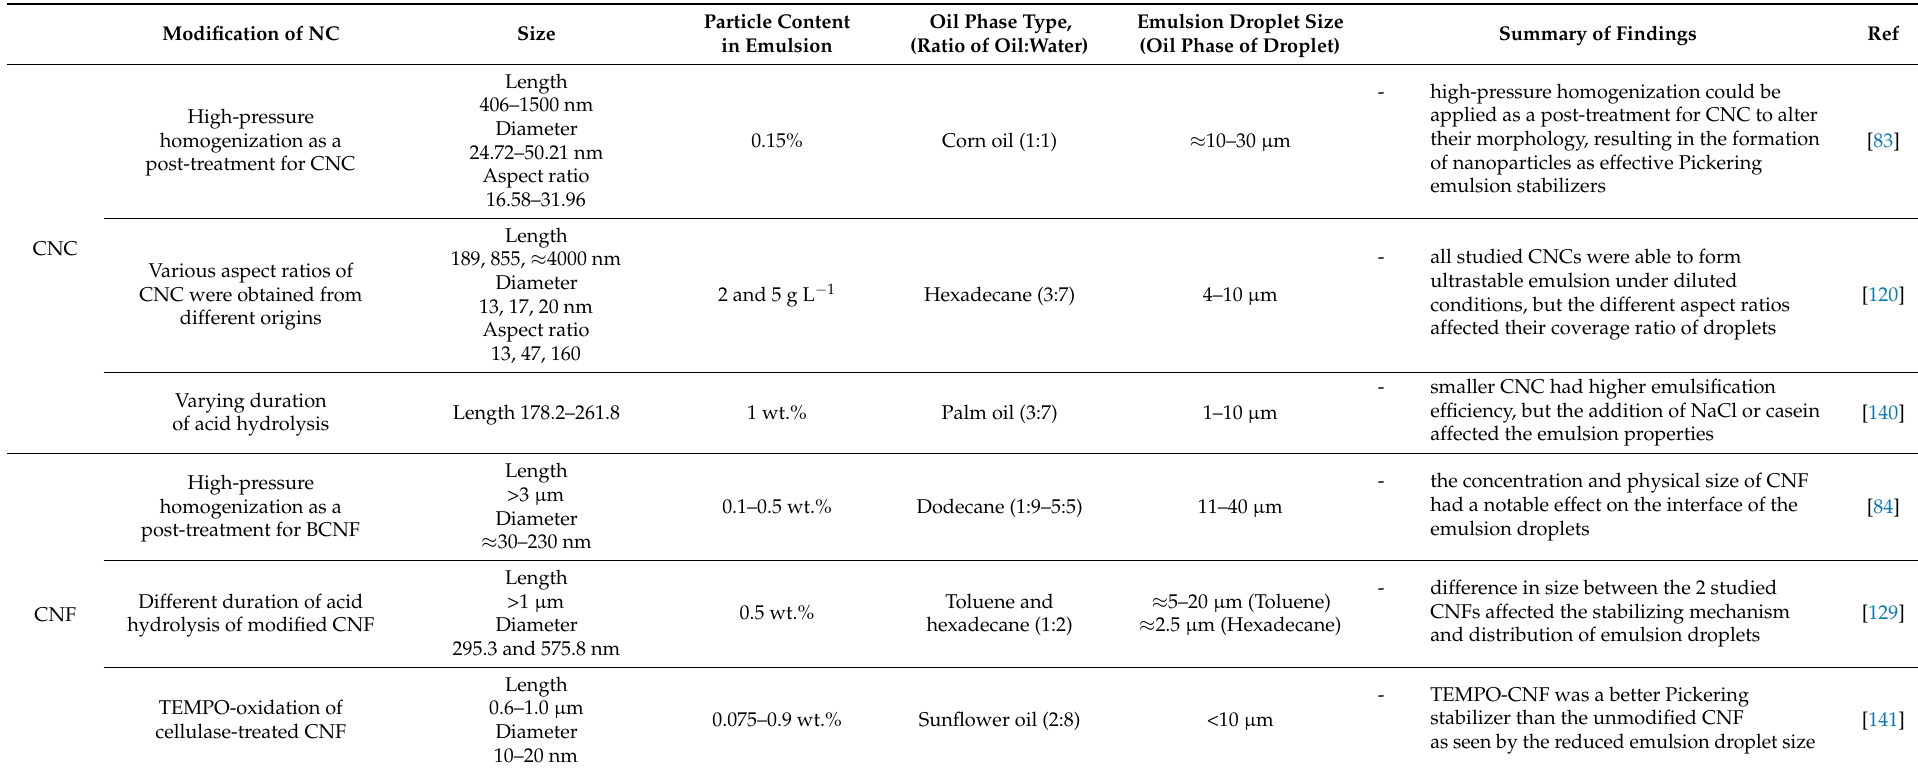
Table 6. Summary of scientific studies on the different morphology of CNC and CNF derivatives in their use as Pickering